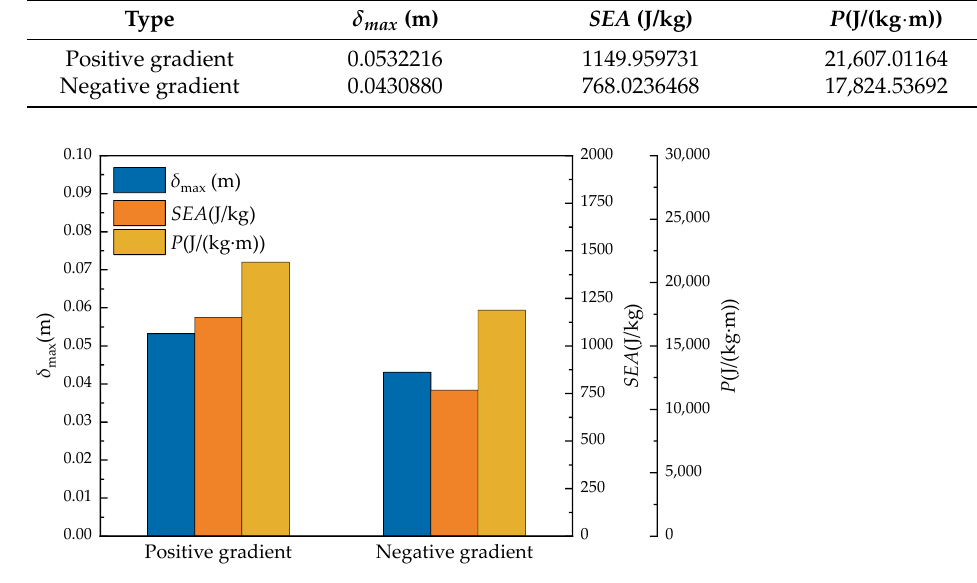
Figure 23. Anti-blast index diagram of two gradients.